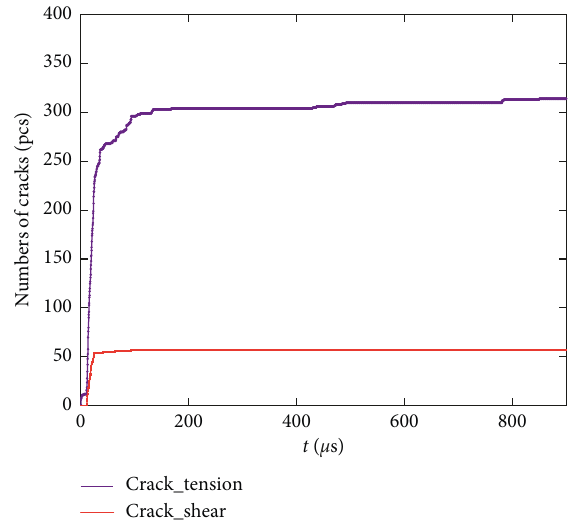
Figure 10: Cumulative numbers of tension and shear cracks with time during rock breaking.